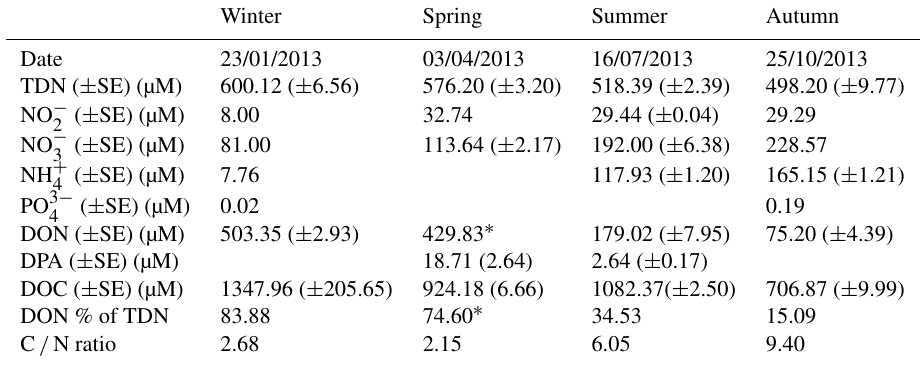
Table 2. Wastewater effluent nutrient content for the different seasons sampled. C:N ratio is calculated as the ratio DOC:DON